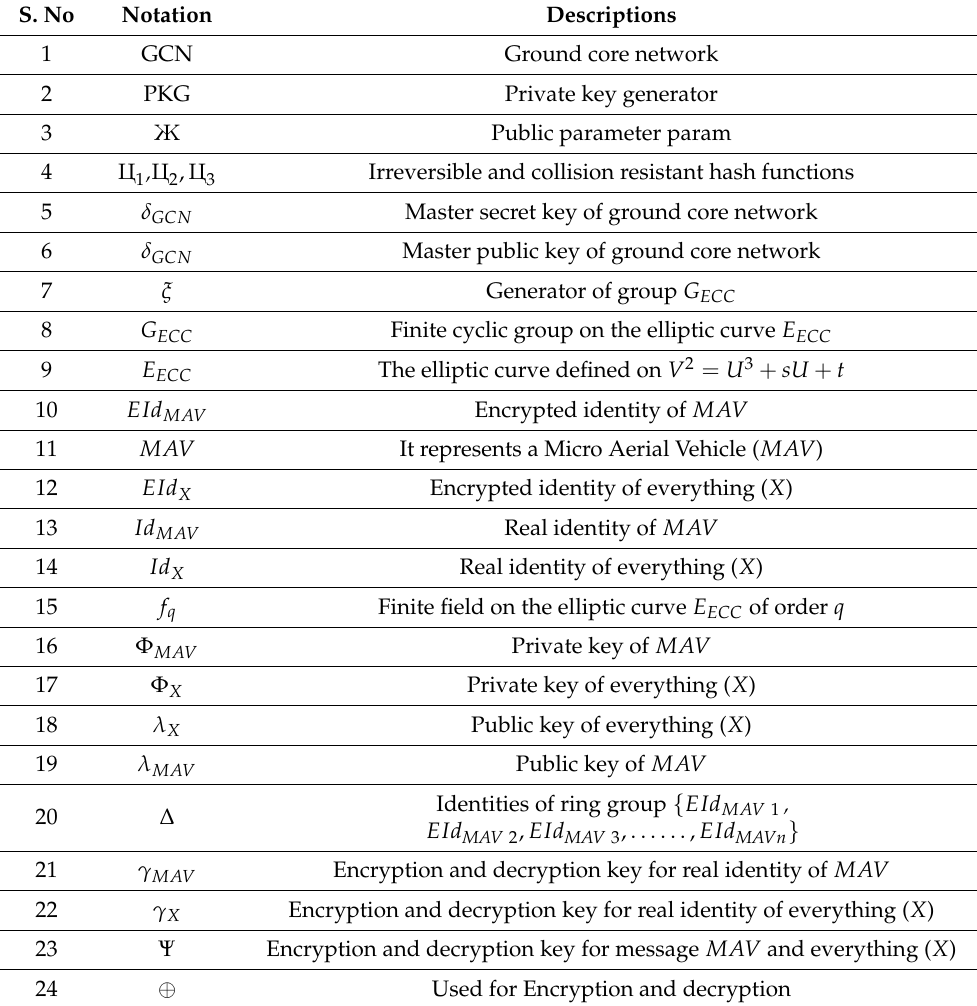
Table 1. Notation